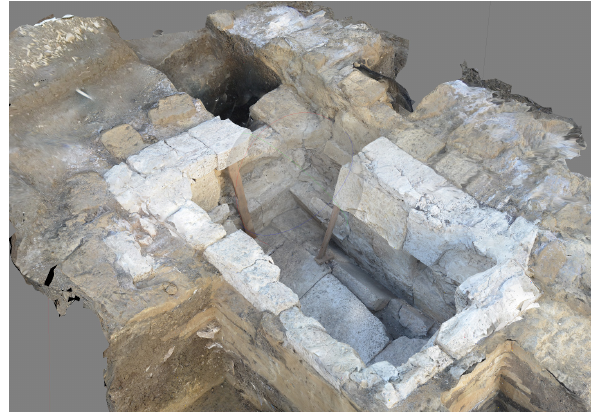
Figure 3. A photogrammetric 3-D model of the central burial of the Bour-gora mound, necropolis of Phanagoria.